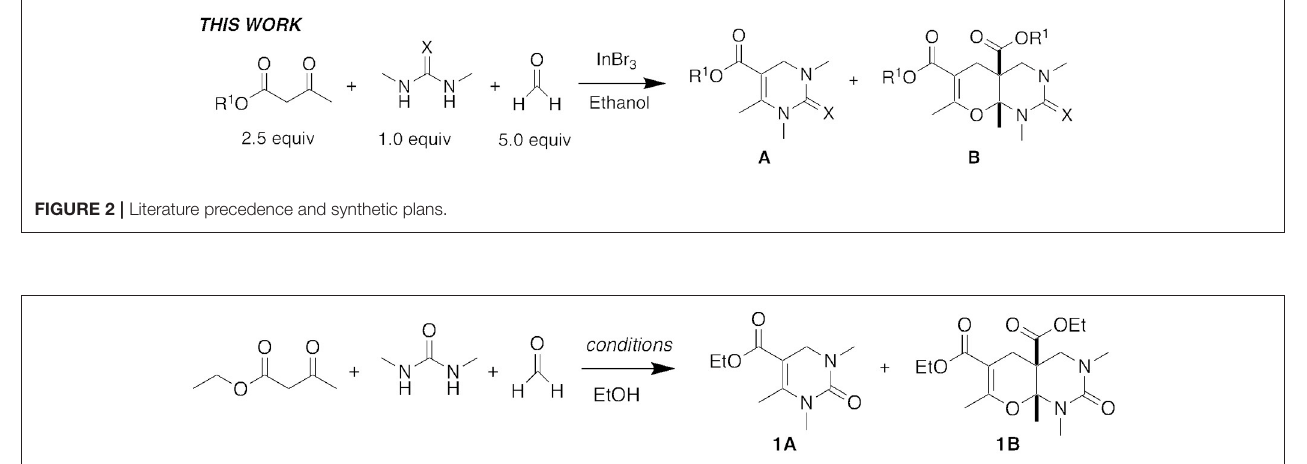
FIGURE 3 | Five-component condensation reaction. For conditions, see Table 1